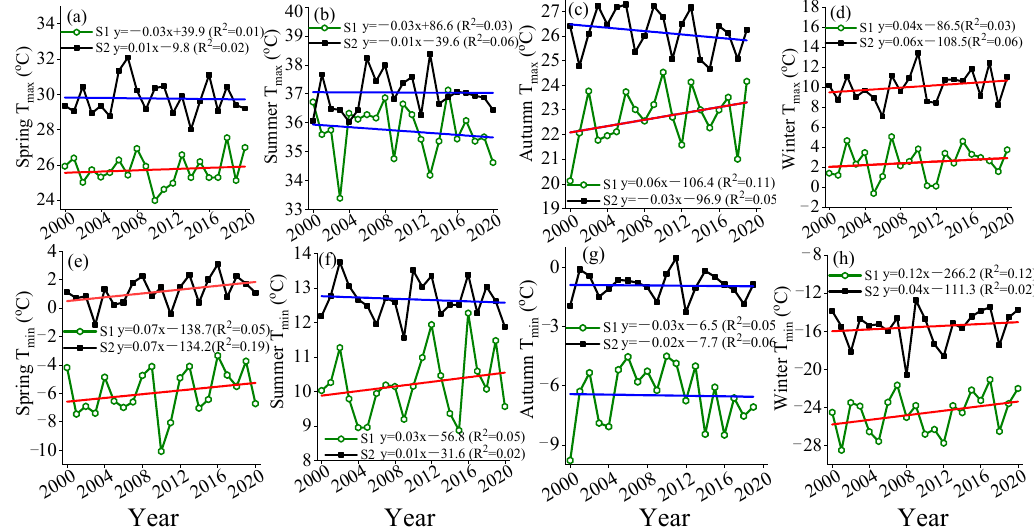
Figure 3. Seasonal T max and T min temperature trends in the studied regions S1 and S2, ( a ): spring T max , ( b ): summer T max , ( c ): autumn T max , ( d ): winter T max , ( e ): spring T min , ( f ): summer T min , ( g ): autumn T min , ( h ): winter T min . S1 and S2 represent two regions of the study area. The DNW rates in S1 and S2 were asymmetrical in the four seasons. The warming rates of T